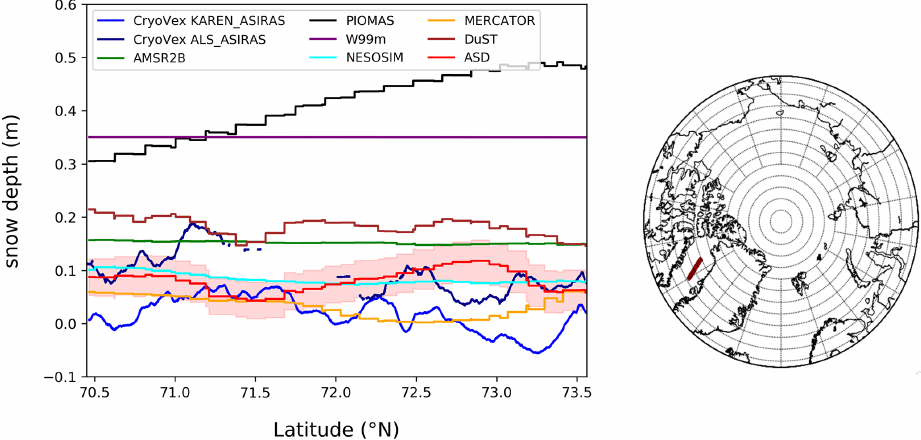
Figure 9. Along-track comparison, in the Arctic, between the snow depth products (models and satellites) and the CryoVEx snow depth data calculated from the Ka-band KAREN radar (blue) and the ALS laser (dark blue) with the Ku-band ASIRAS radar during the 31 March 2017 campaign. The map specifies the geographical location of the CryoVEx